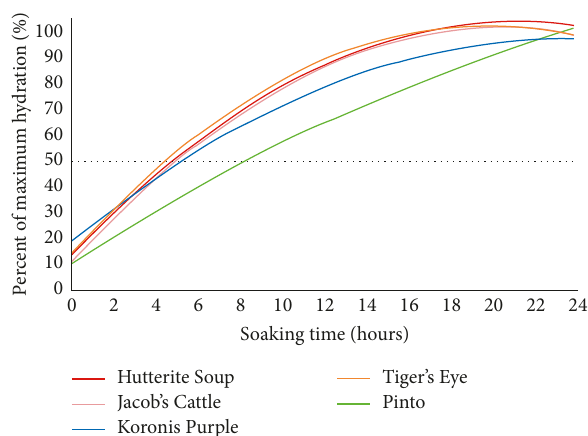
Figure 1: Water absorption of beans during